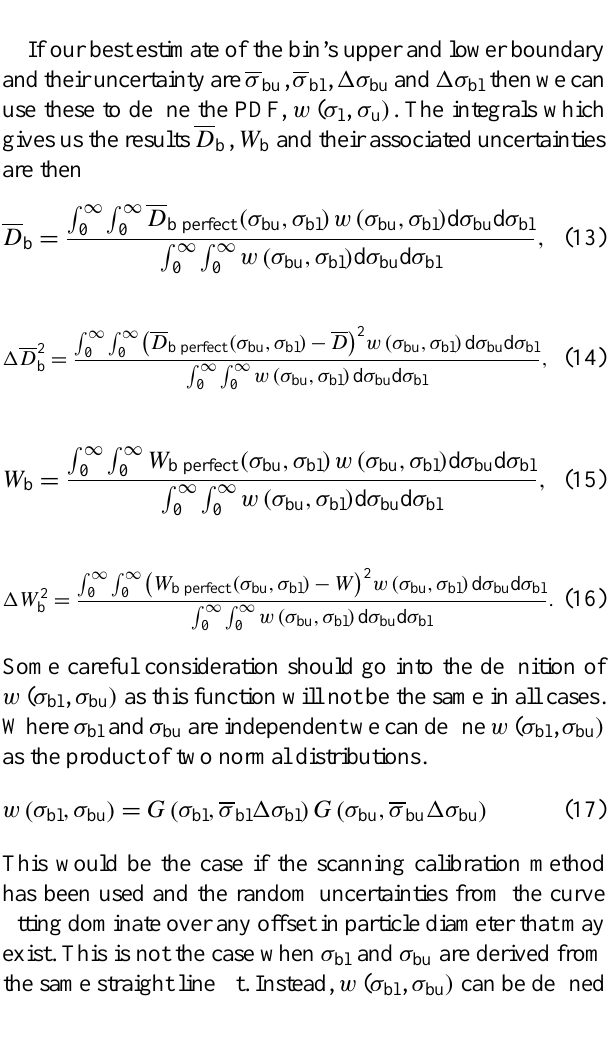
Fig. 8. Example showing the range of sizes of PSL spheres which would fall within a single bin of a PCASP. The grey shading covers all diameter ranges where the Mie-Lorenz curve falls between the horizontal dashed lines derived from calibration. The mean diame- ter of the shaded regions, W b perfect , is shown as a vertical red line. The vertical dotted lines show the manufacturer’s boundaries for the same